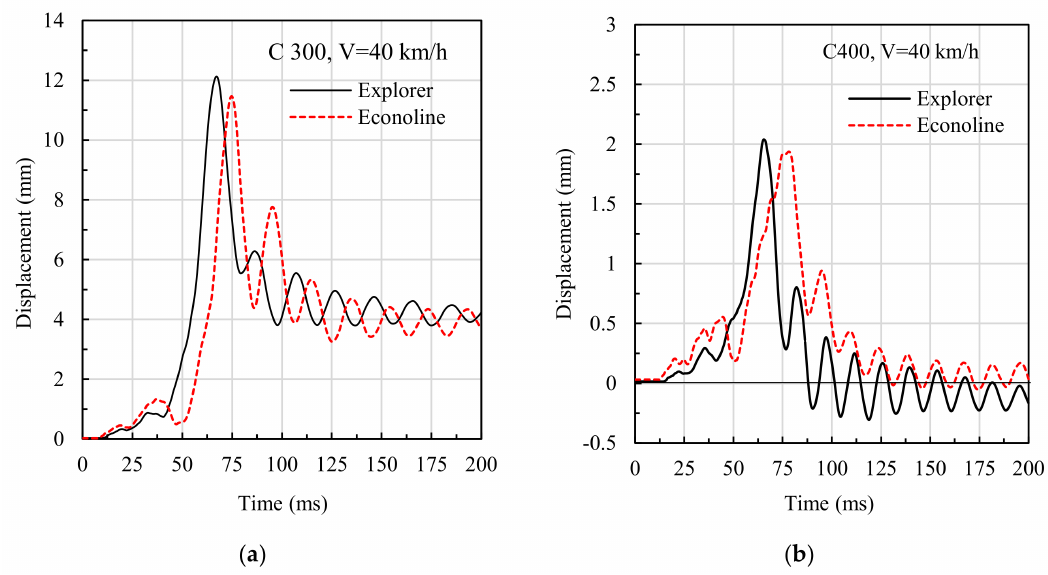
Figure 14. Lateral displacement time histories at 1740 mm height of the columns during the car crash with a velocity of 40 km/h: ( a ) column size 300 × 300 mm; ( b ) Column size 400 × 400